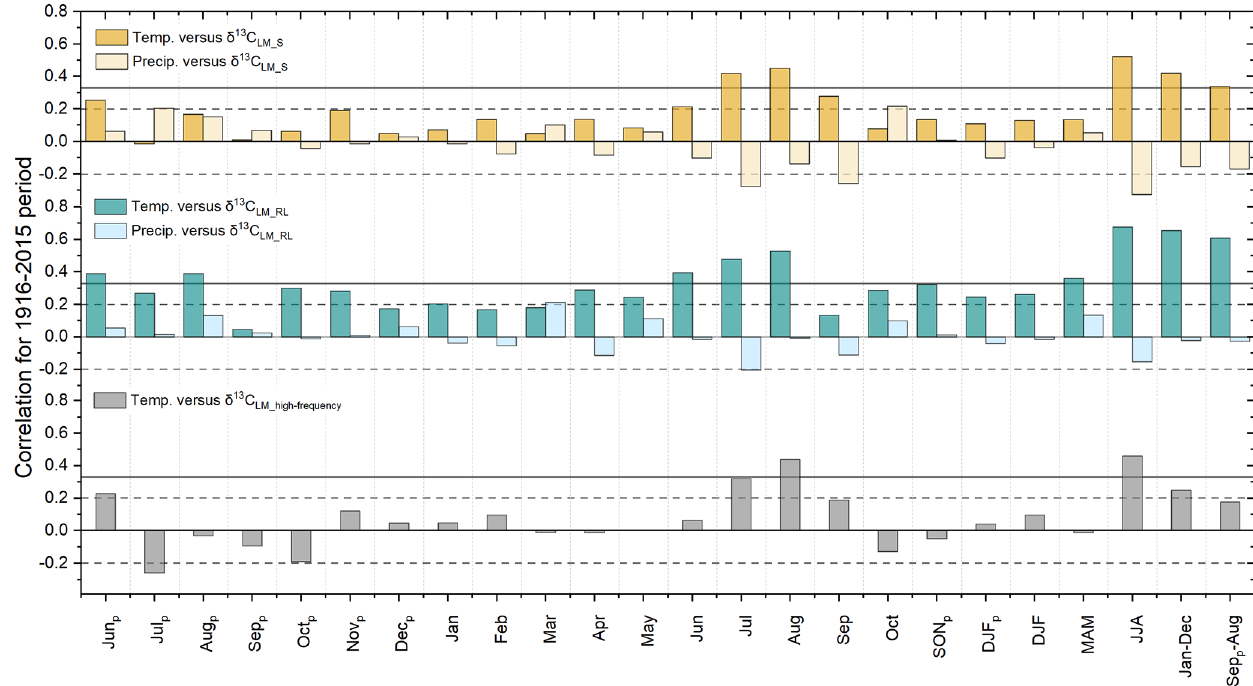
Figure 4. Correlation coefficients between corrected δ 13 C LM_S , δ 13 C LM_RL , δ 13 C LM_high-frequency chronologies and local temperatures and precipitation totals from 1916 to 2015. The subscript p indicates the months of the previous year, and horizontal lines indicate the significance levels, with solid lines representing highly significant ( p < 0 . 001) and dashed lines representing significant values ( p < 0 . 05).